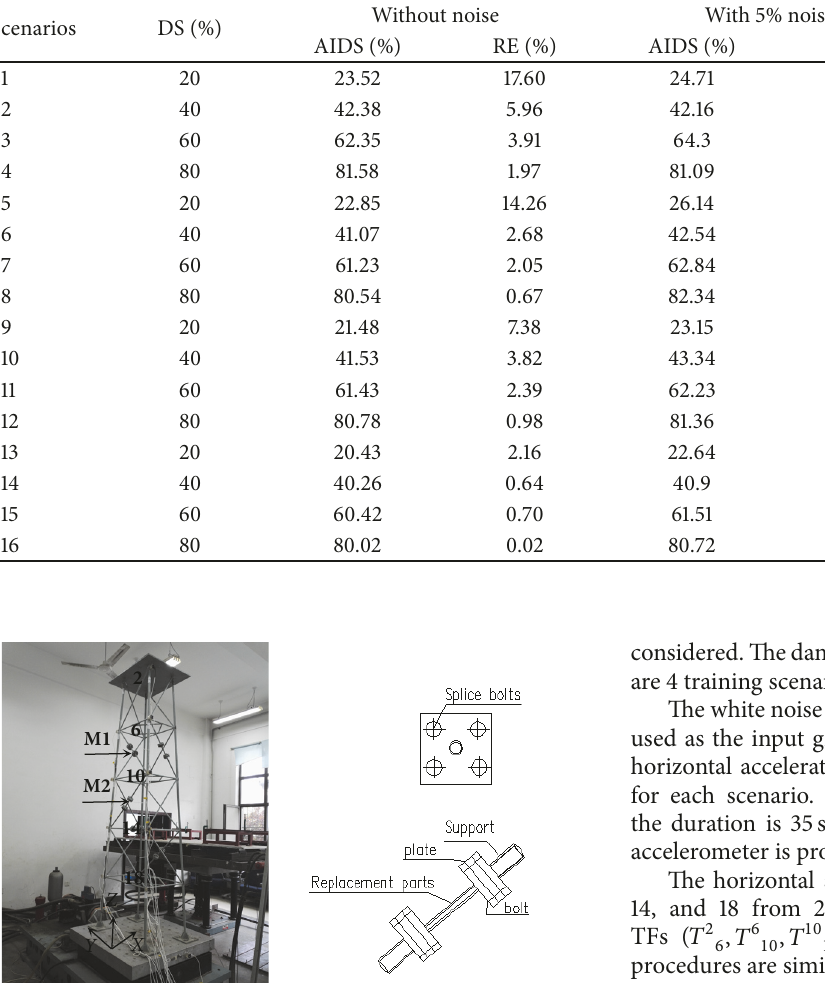
Table 8: Average of identified damage severities based on PC and SVM.